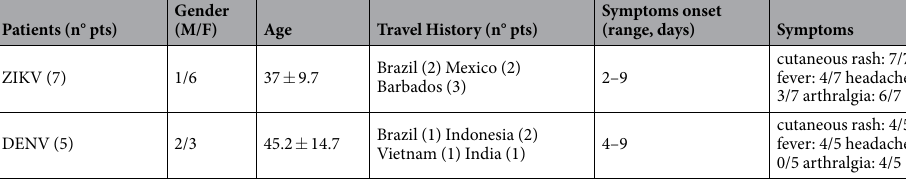
Table 1. Clinical features of enrolled